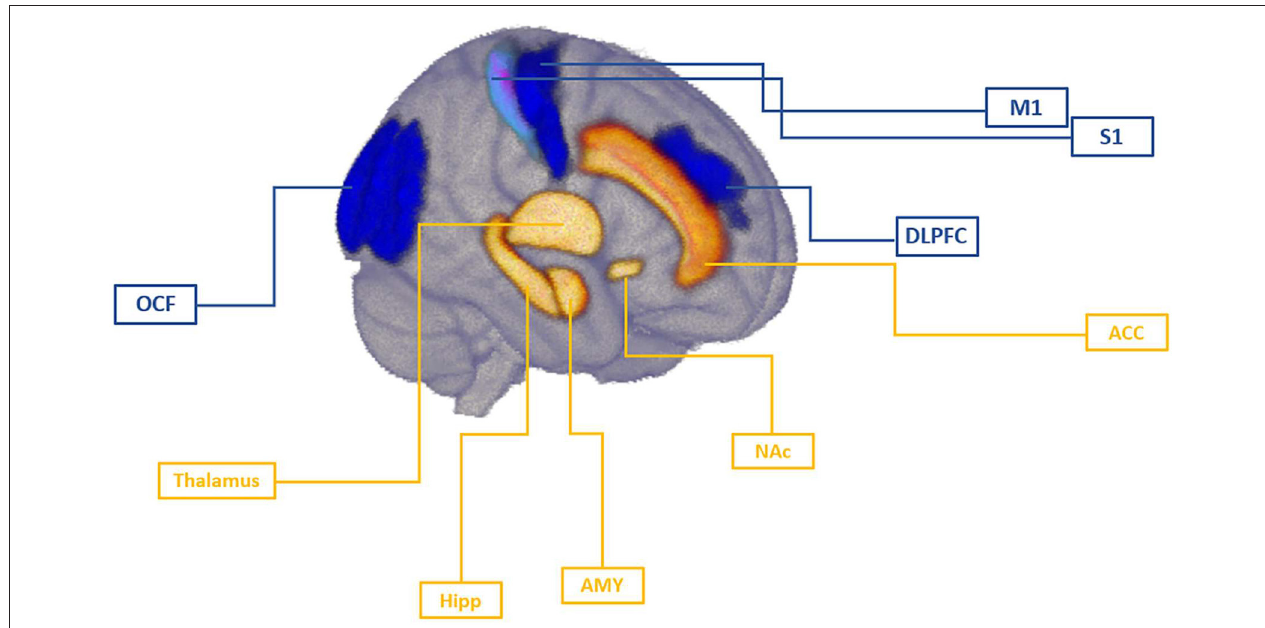
FIGURE 1 | Brain targets involved in the mechanism of pain chronicity. Cortical targets of NIBS studies were primary motor cortex (M1), primary somatosensory cortex (S1), dorsolateral prefrontal cortex (DLPFC), and occipital field (OCF). Imaging studies have identified thalamus, hippocampus (Hipp), amygdala (AMY), and nucleus accumbens (NAc) as key subcortical regions implicated in pain chronicity. Anterior cingulate cortex (ACC) has been identified as an important relay in the medial pain pathway integrating sensory, attentional, and motivational components of pain that can also been targeted via cortical stimulation due to its interconnections with these targets. In tonic, acute pain stage, motor cortex, as well as somatosensory regions may undergo rapid changes as response to peripheral insult, and the magnitude of this response might be shaped by pre-existing individual differences within these regions. As demonstrated in NIBS studies, DLPFC regulates top-down inhibition of pain independently of motor cortex activation, possibly modulating sensory component in an early stage of pain development. As pain develops to the chronic stage, cognitive aspects of pain become more important mechanism and prefrontal regions may regulate the affective component of pain via their influence on cingulate and limbic